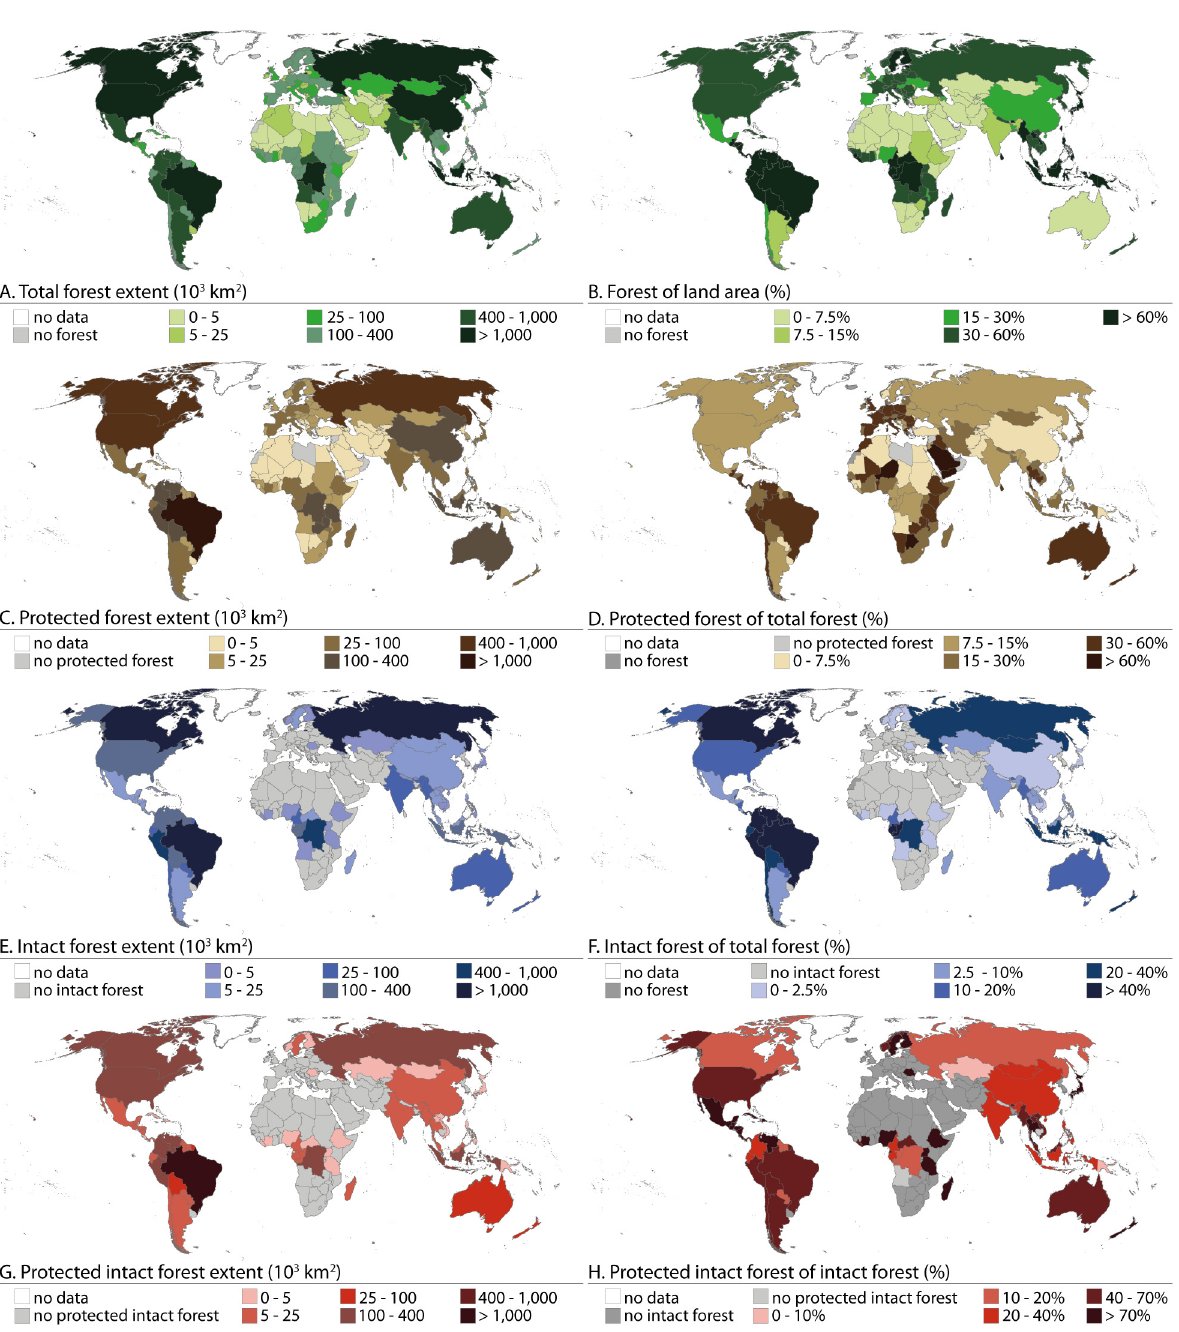
Fig 2. Absolute and relative forest extent by country in year 2000. Absolute forest extents (left column) are presented in km 2 and relative forest extents (right column) are in %. A and B) Total forest extent; C and D) Protected forest extent; E and F) Intact forest extent; G and H) Protected intact forest